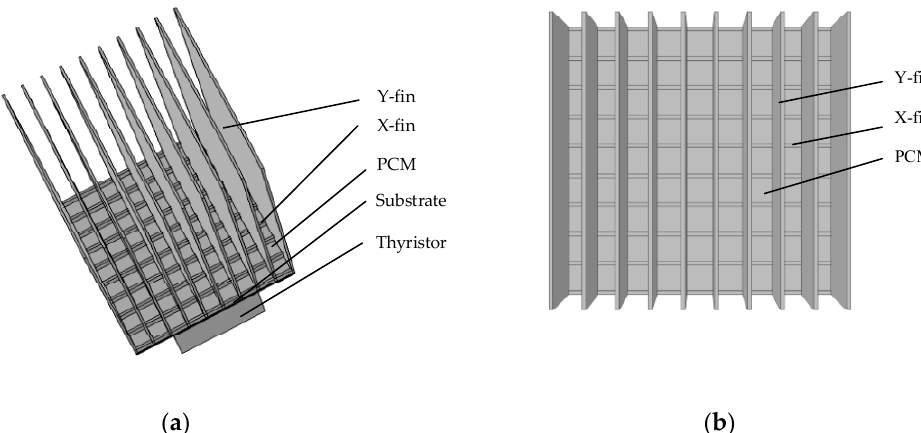
Figure 1. Schematic diagram of the PCM heat sink with mesh-finned structure ( a ) The structure of the model; ( b ) the top view of the model.